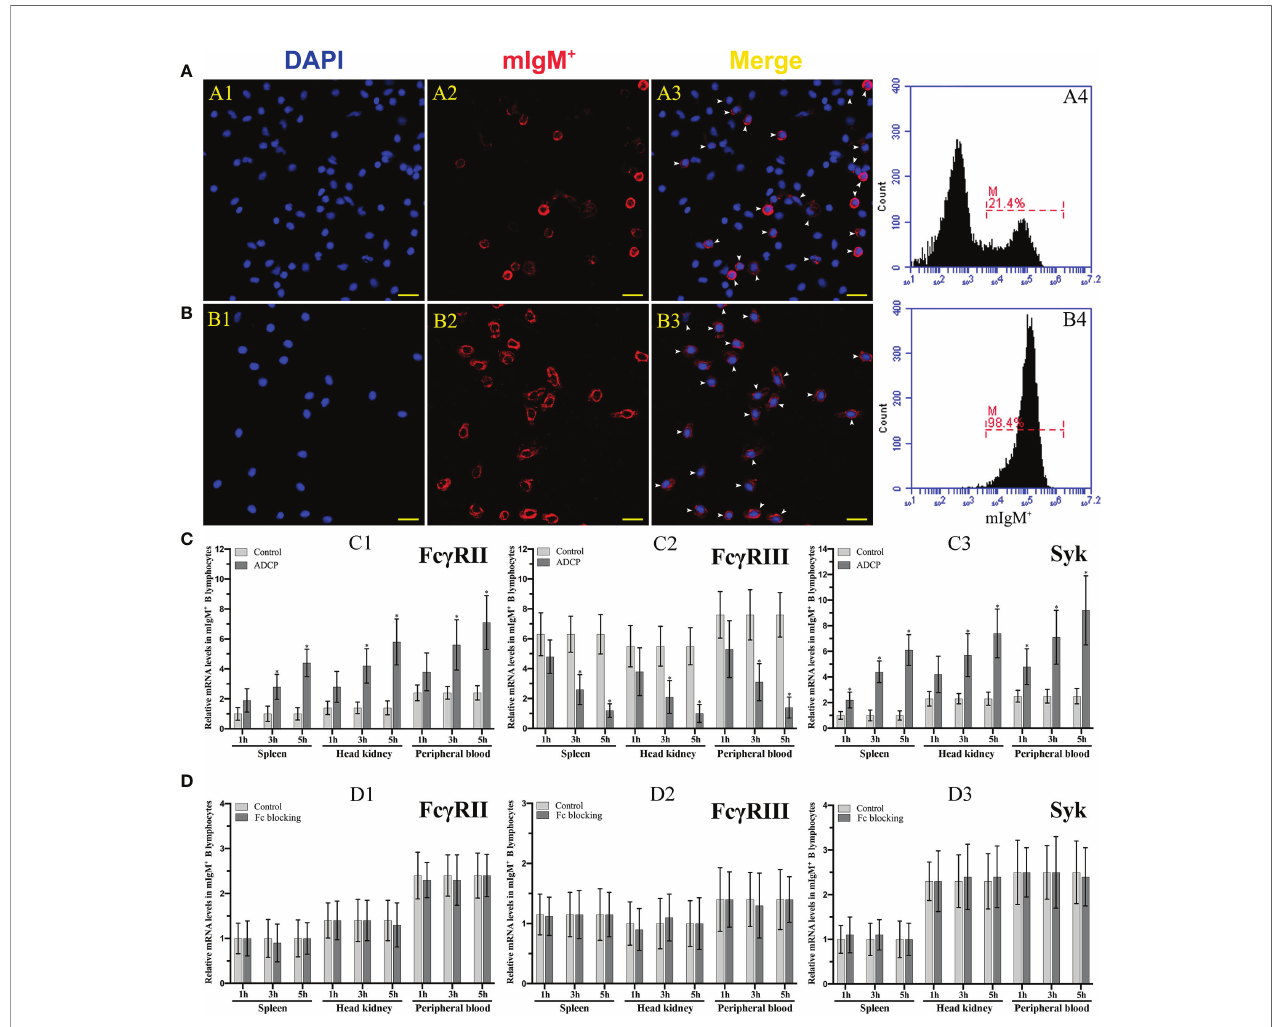
FIGURE 6 | Analysis of the purity of sorted mIgM + B lymphocytes and expression levels of ADCP-related genes after their phagocytosis. (A, B) Analysis of the percentage of mIgM + B lymphocytes in unsorted (A) and sorted (B) cells by IFA and fl ow cytometry. A1 and B1: DAPI staining of cell nuclei. A2 and B2: Immuno fl uorescence-stained with anti-IgM mAb and Alexa Fluor ® 649 goat anti-mouse IgG. A3 and B3: Merge images of each fl uorescent channel and arrows indicate the mIgM + B lymphocytes (Bar = 20 m m). Fluorescence histogram showed the percentage of mIgM + B lymphocytes (scale of M) in unsorted leukocytes (A4) and sorted mIgM + B lymphocytes (B4). (C, D) The qRT-PCR analysis of the expression levels of ADCP-related genes in mIgM + B lymphocytes post incubation with antiserum-opsonized (C) and Fc blocked E. tarda (D) , respectively. C1 and D1: Fc g RII. C2 and D2: Fc g RIII. C3 and D3: Syk. Error bars indicate the standard deviation of the three biological replicates. The asterisks on the bars represent the statistical difference of genes expression compared to the control group ( p <